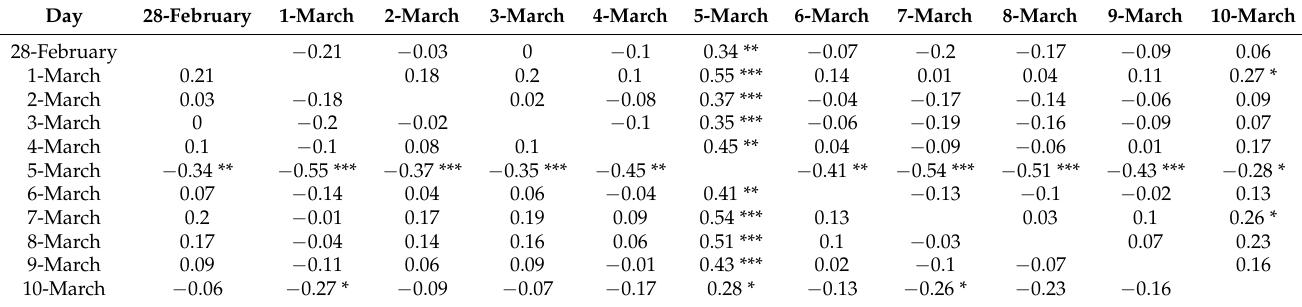
Table 5. Post hoc test for all pairwise comparisons of LMF-HRV-correlation mean between days for the Lithuania’s group (* p < 0.05, ** p < 0.01, *** p < 0.001).